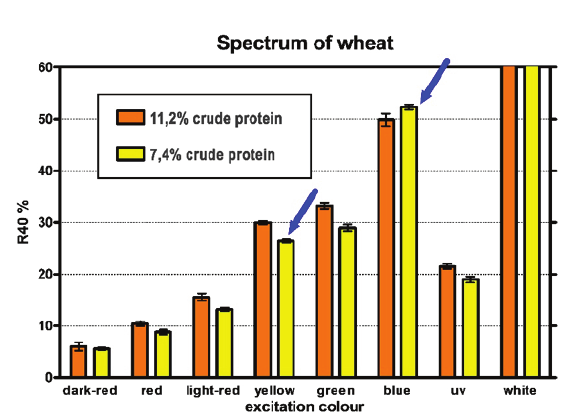
were lower for the beans of biodynamic origin and for